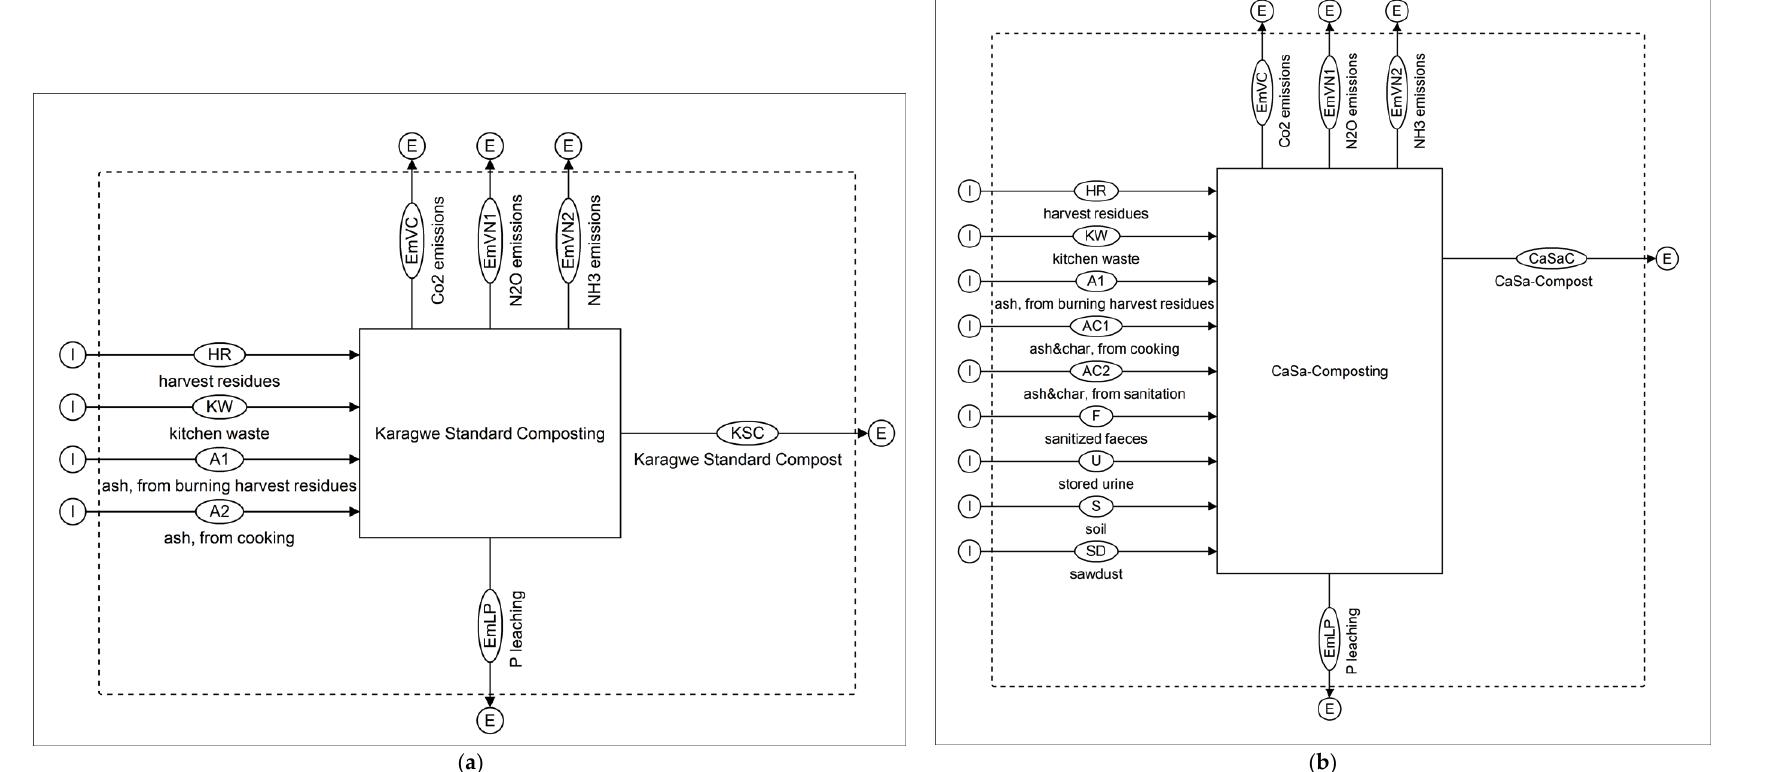
Figure 2. Flow charts showing in- and output flows of materials considered in modelling Karagwe standard composting ( a ) and CaSa-composting ( b ). Processes are indicated with boxes, material flows with arrows. A: ash; AC: ash and char; CaSaC: CaSa-compost; EmVC: emissions of carbon through volatilization; EmVN: emissions of nitrogen through volatilization; EmLP: emissions of phosphorus through leaching; F: faeces; HR: harvest residues; KSC: Karagwe standard compost; KW: kitchen waste; S: soil; SD: sawdust; U: urine.